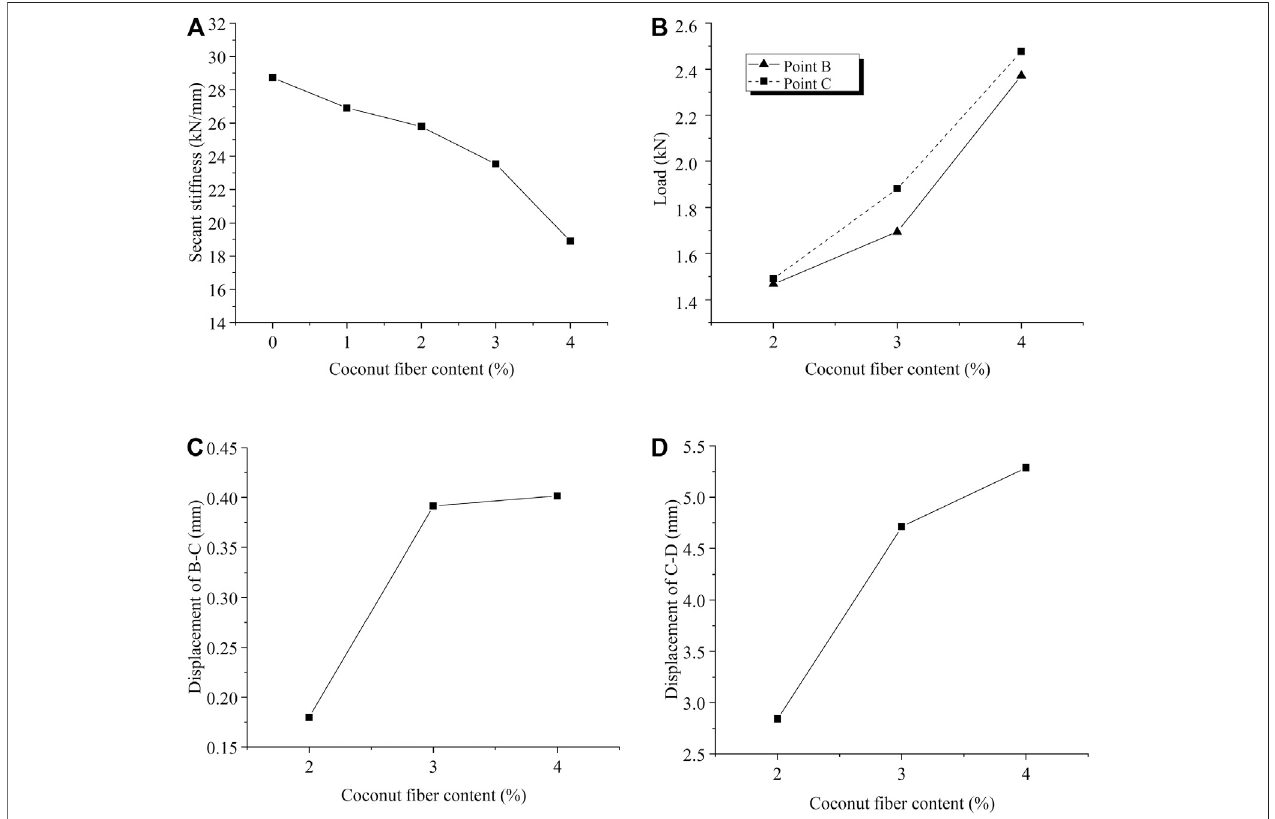
FIGURE 13 | Experiment result and analysis (A) secant stiffness of O-A; (B) loading force at points B and C; (C) the displacement of B-C; (D) the displacement of C-D.